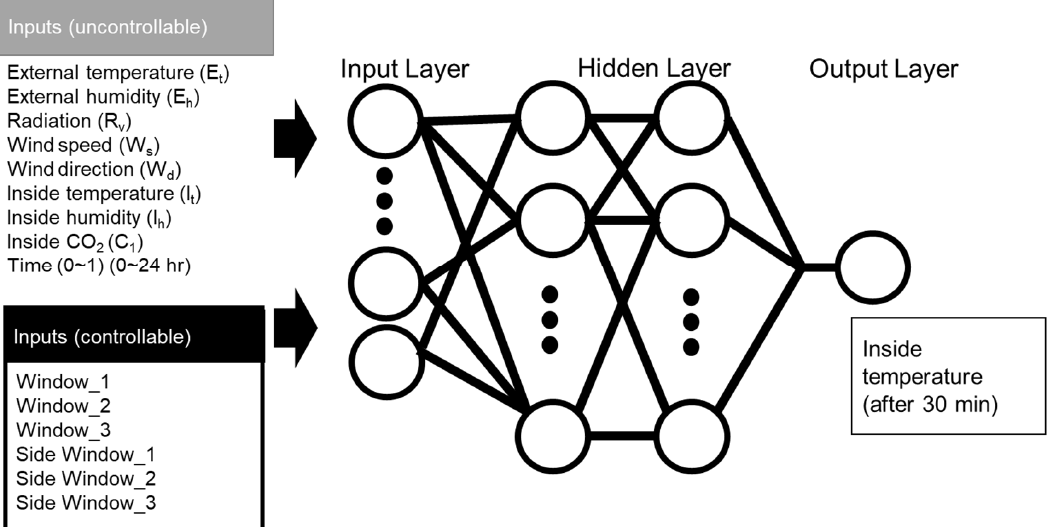
Table 2. Functions used in the artificial neural network hidden nodes.